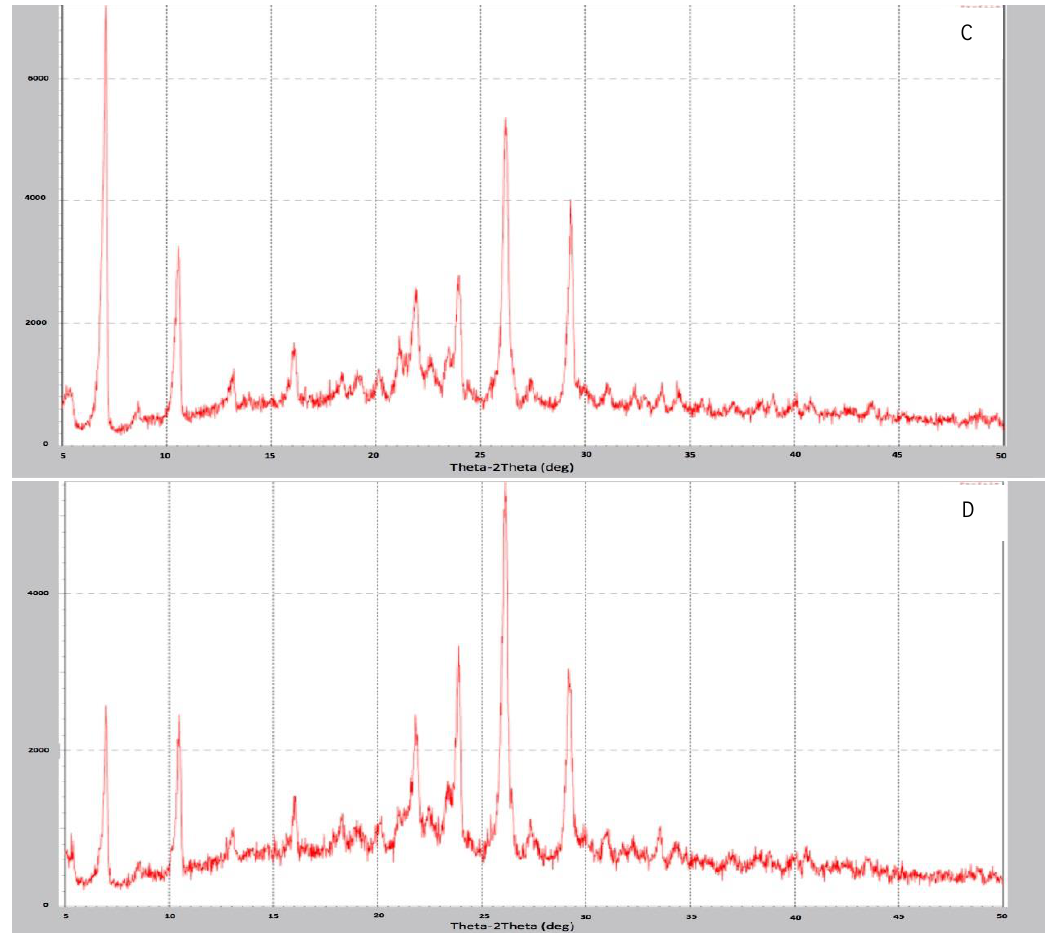
Figure 4b. XRD of Physical mixture [C] microsponge F2 [D].